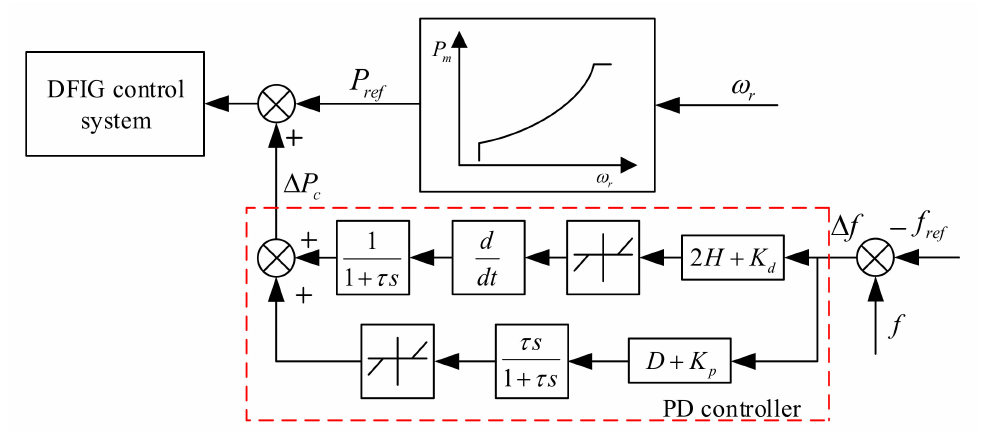
Figure 3. Additional power outer loop for inertial emulation